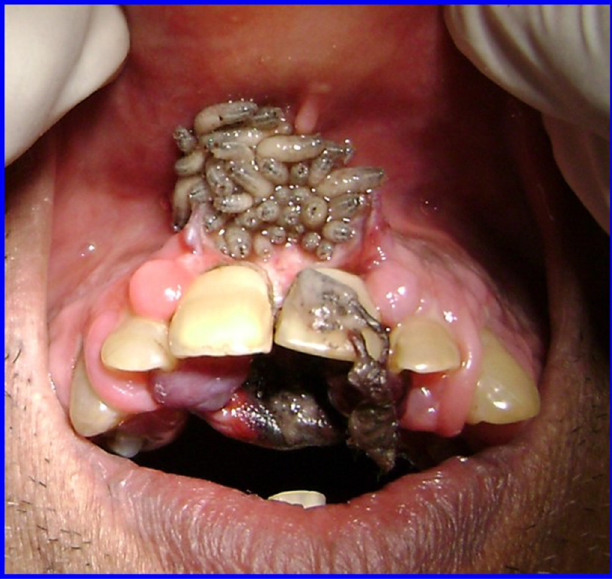
Fig. 2. Intraoral photograph showing maggots in upper labial vestibule.